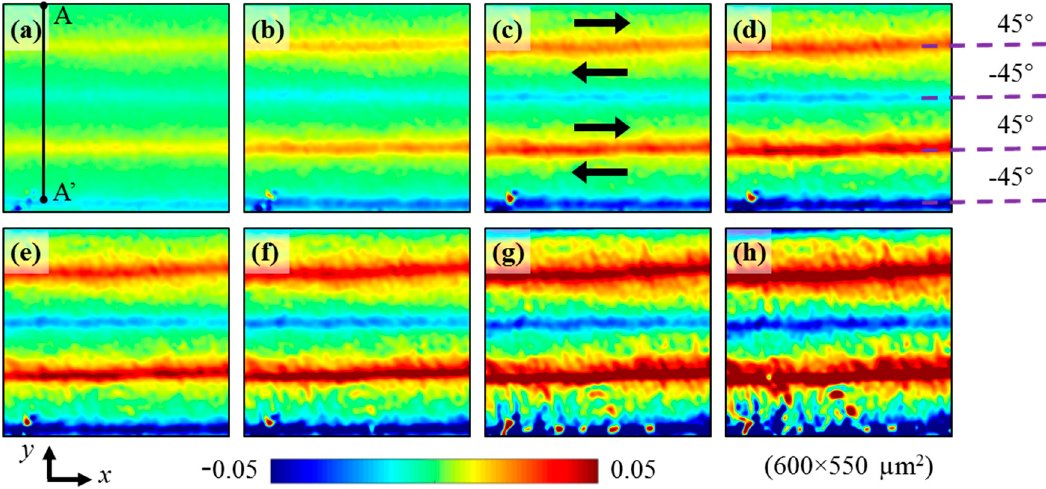
Figure 9. Evolution of the shear strain distributions of CFRP at ( a ) 127 MPa, ( b ) 199 MPa, ( c ) 238 MPa, ( d ) 258 MPa, ( e ) 272 MPa, ( f ) 292 MPa, ( g ) 313 MPa, and ( h ) 327 MPa, where the arrows show the relative slip directions of different layers.